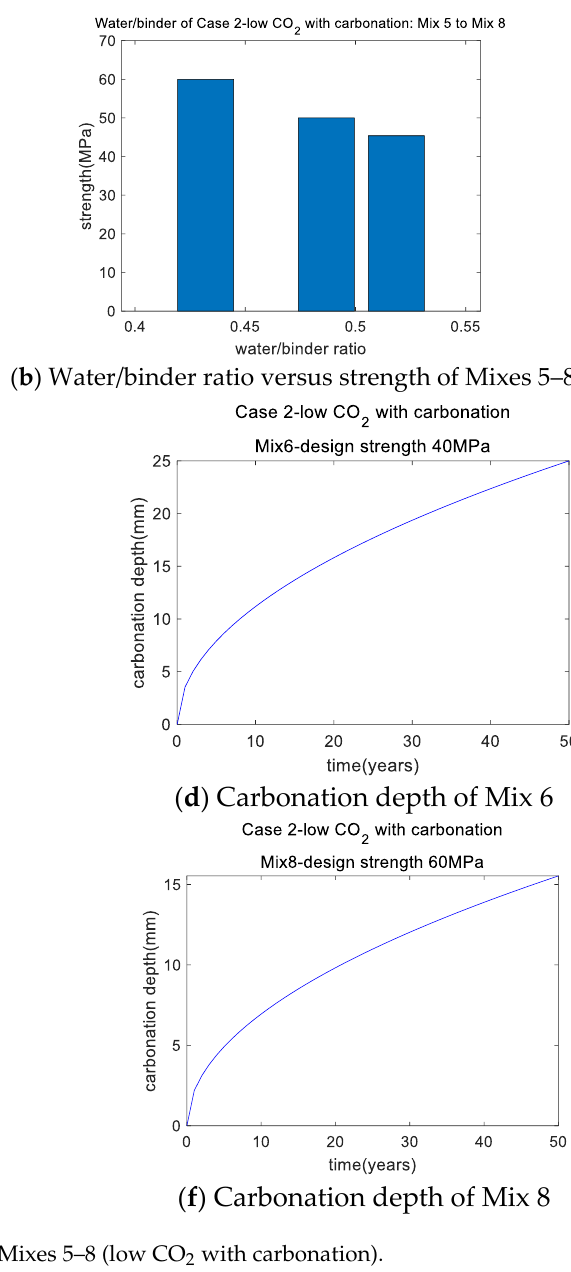
2 with carbonation).